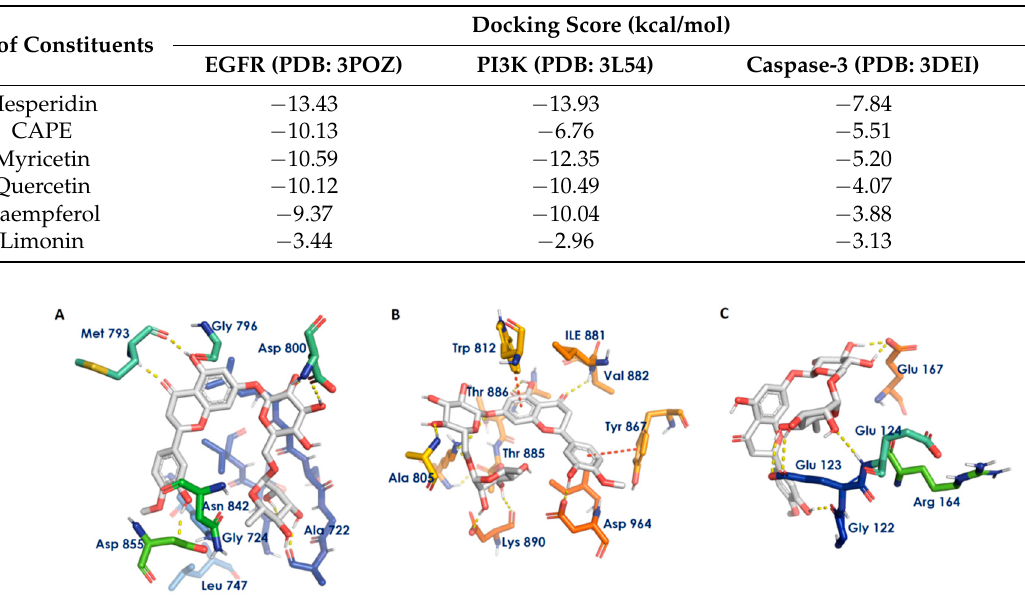
Table 3. In silico anticancer potential of propolis constituents.